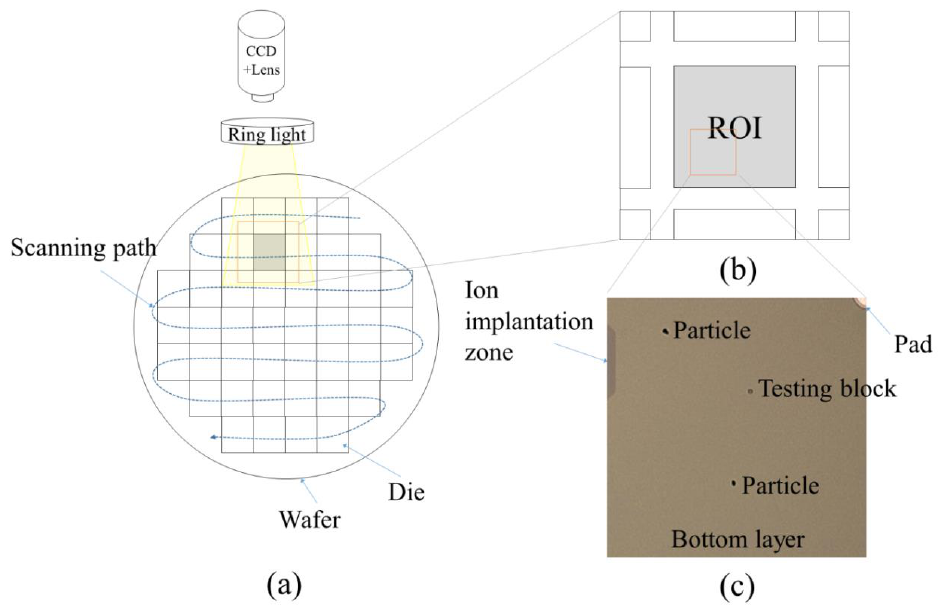
Figure 2. The image-capturing system and composition of the die. ( a ) The scanning path and field of view ( b ) the ROI die and ( c ) the appearance of die.